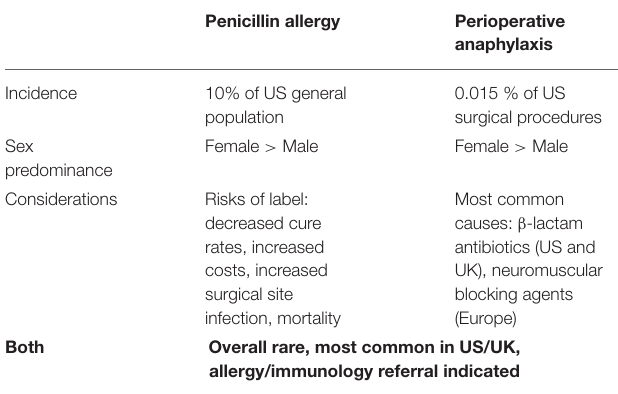
TABLE 1 | Penicillin allergy and perioperative anaphylaxis characteristics. Penicillin